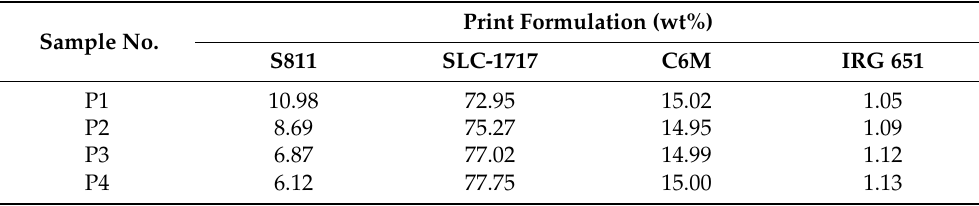
Table 3. Composition of Ch-LC films by ink jet